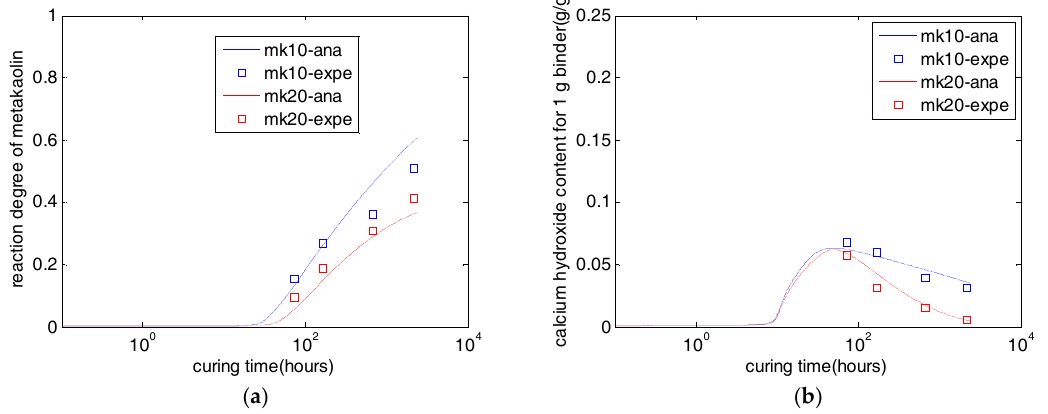
Figure 3. Hydration of cement-MK blends. ( a ) reaction degree of MK; and ( b ) calcium hydroxide content in cement-MK blends (W/B = 0.3).